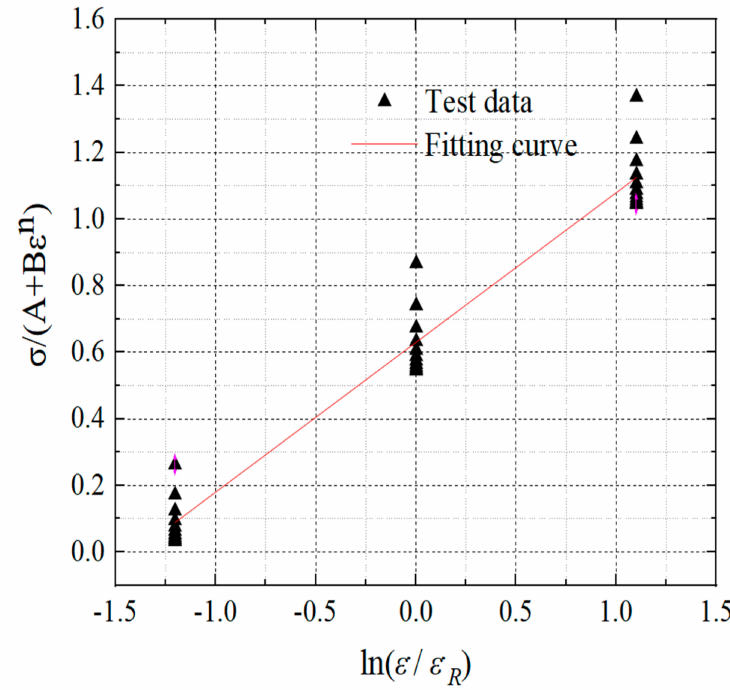
. . ε / ε R ) and σ /( A + B ε n ).